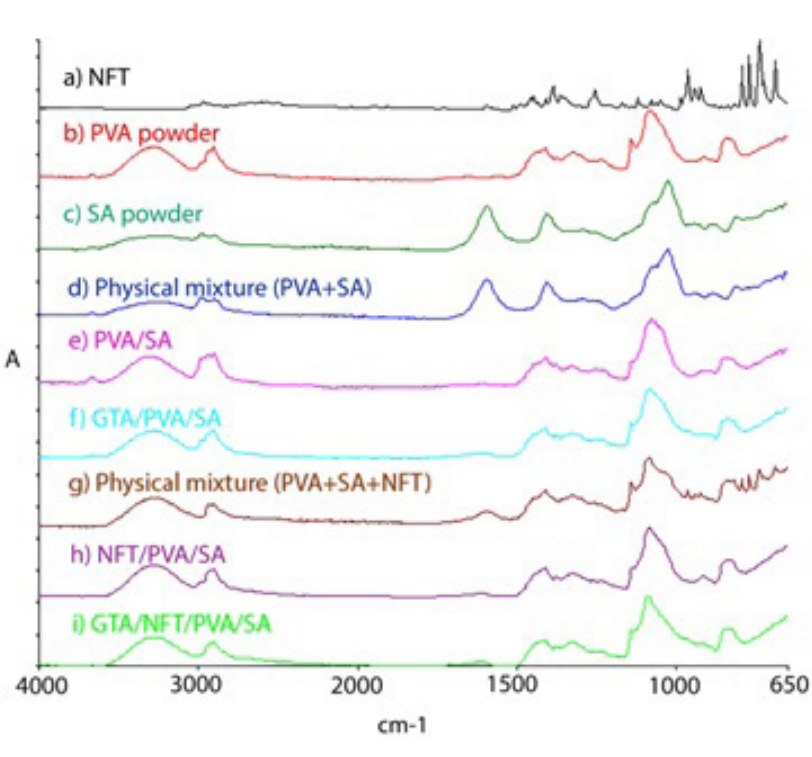
FIGURE 6 - ATR-FTIR spectra of a) naftifine (NFT) b) PVA c) SA d) physical mixture of PVA and SA e) PVA/SA nanofiber f) GTA/PVA/SA nanofiber g) physical mixture of PVA, SA and NFT h) NFT/PVA/SA nanofiber i) GTA/NFT/PVA/SA